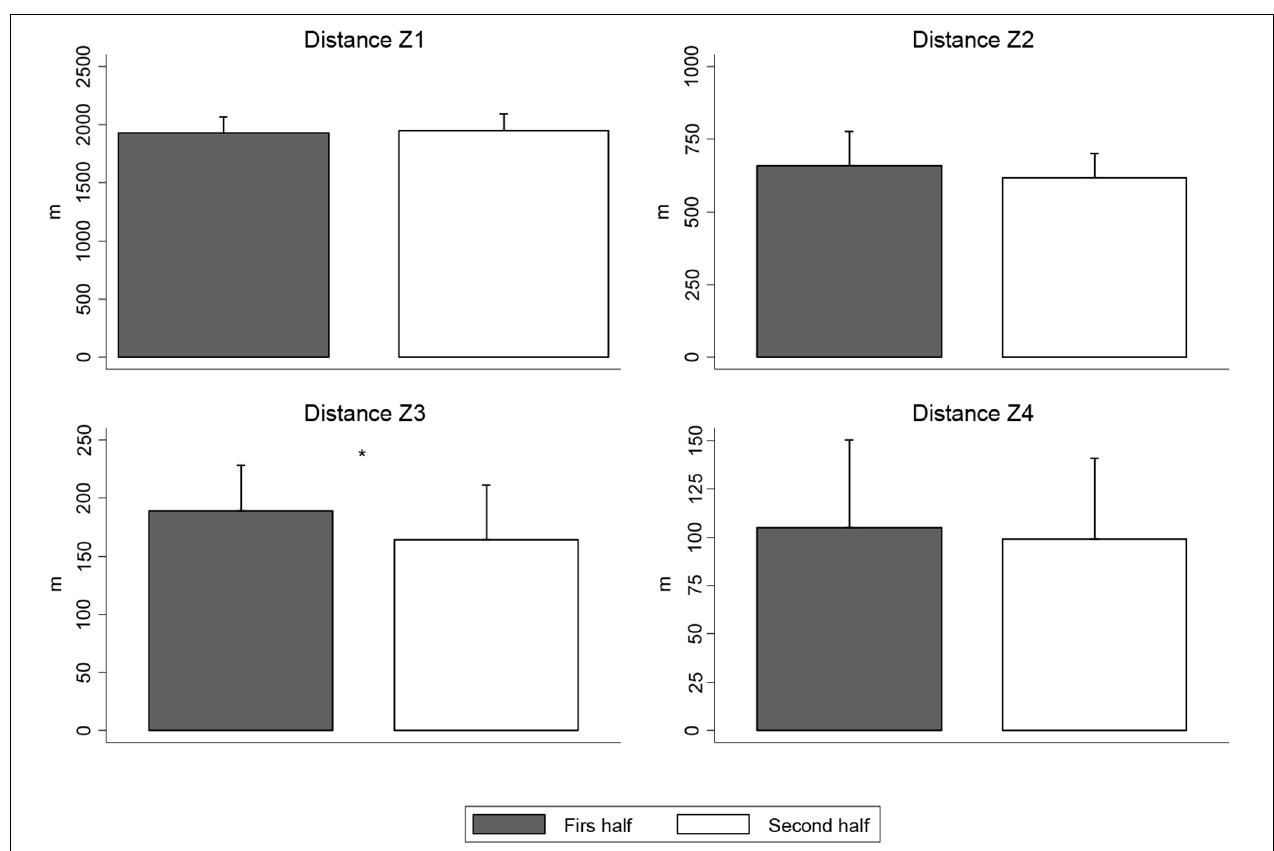
Movement pattern